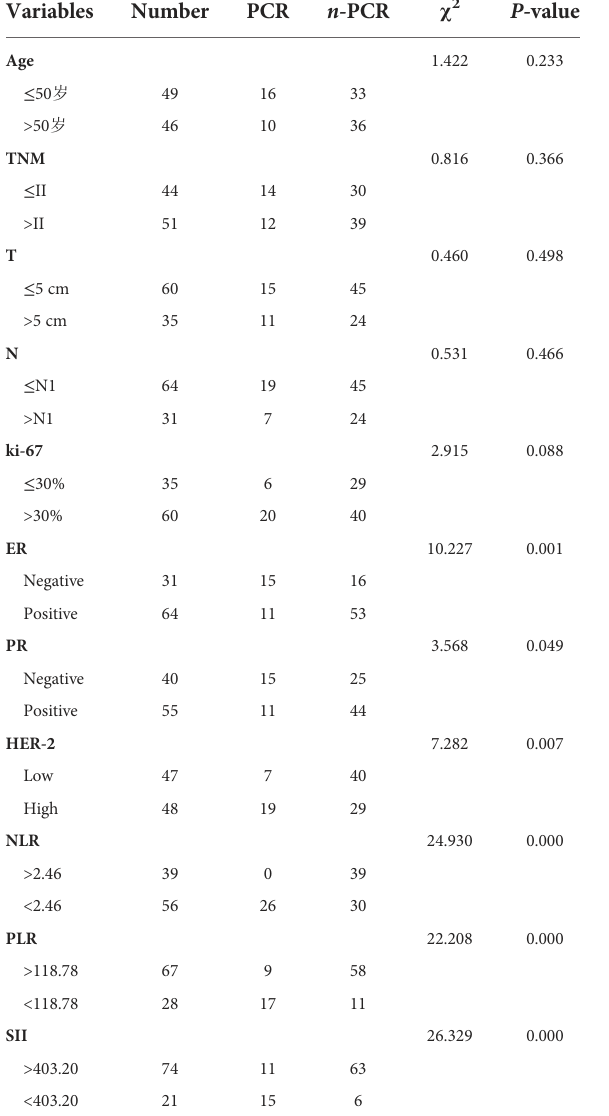
TABLE 2 The relationship between NLR, PLR, SII, PNI and pCR before treatment, after treatment and dynamic